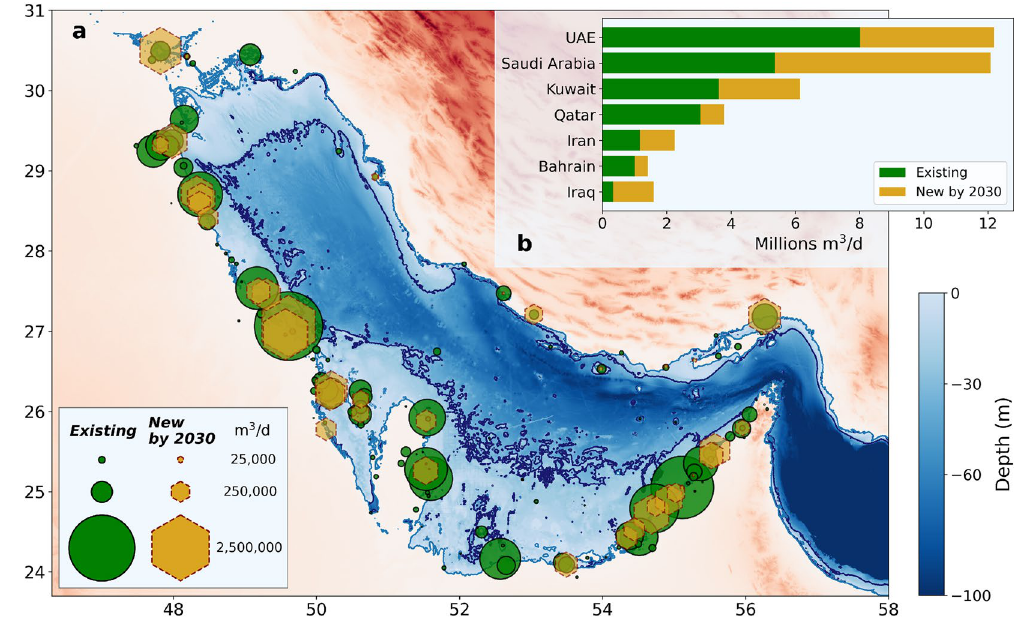
Figure 1. ( a ) Bathymetry of the Gulf region according to the GEBCO 2021 dataset. Elevation zero is marked in light blue, the − 30 m isobath in dark blue. Existing and future (in construction, approved and planned by 2030) desalination plants impinging on the Gulf are marked, respectively by circles and hexagon markers. The marker area is proportional to the plant desalination capacity. Plants closer than ~10 km are represented as a single plant with the combined capacity. ( b ) Existing and future desalination capacity per country. Oman has been omitted because its desalination capacity in the Gulf amounts to only 5150 m from 2 . Map produced with Python 3.10.6: https:// www. python.